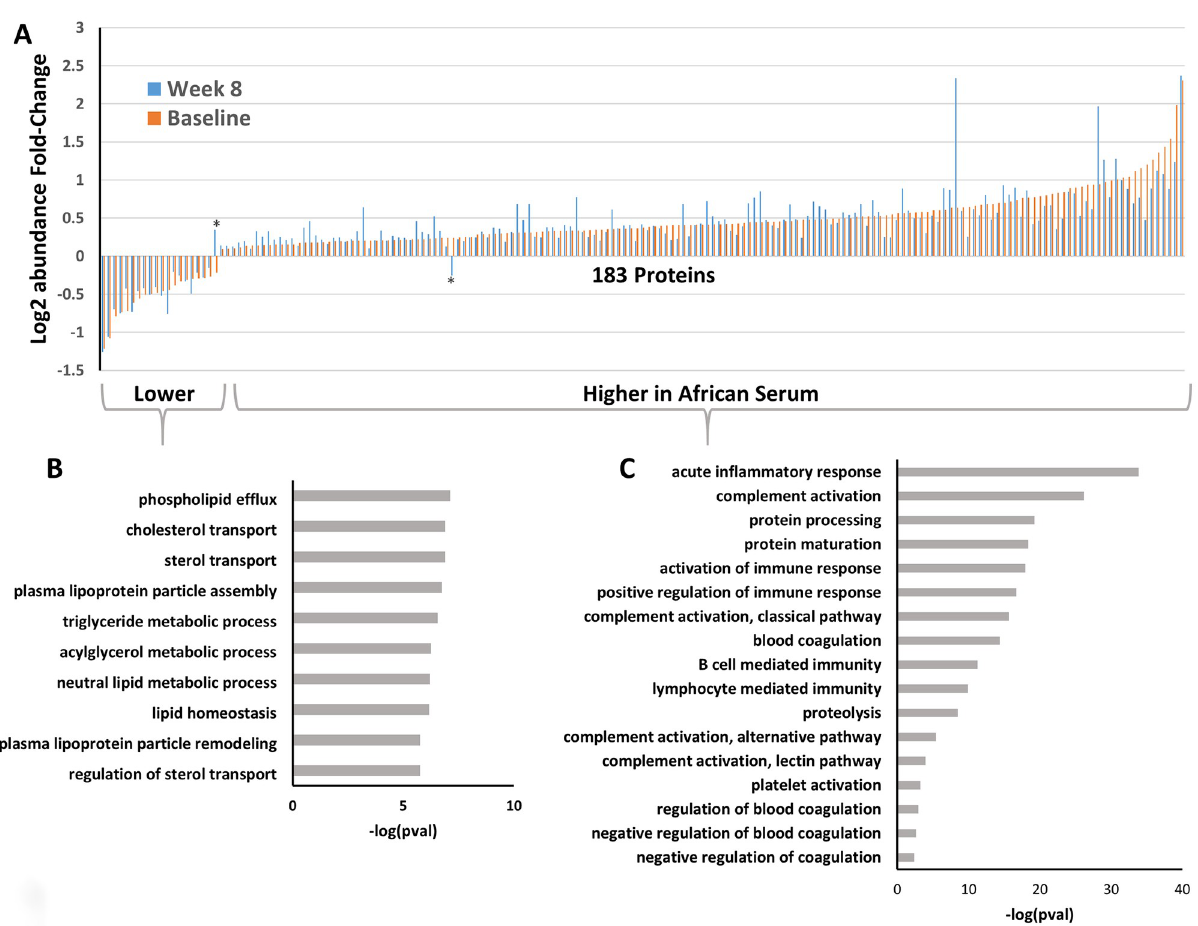
Fig 2. Characterization of the 183 African/non-African discriminatory core protein signature. Shown in A) is the fold change difference in abundance between African and non-African TB patient population for each of the 183 proteins in rank order. Negative, lower, fold change is in reference to the African population. Asterisks mark two proteins SHBG and TIMP1, which change directionality between baseline and week 8 results, where all other proteins show similar directionally of change between these two time point datasets. B) Gene Oncology (GO) annotations with Bonferroni adjusted p-values generated via DAVID show those pathways downregulated in African populations. C) Protein pathways upregulated in African populations.